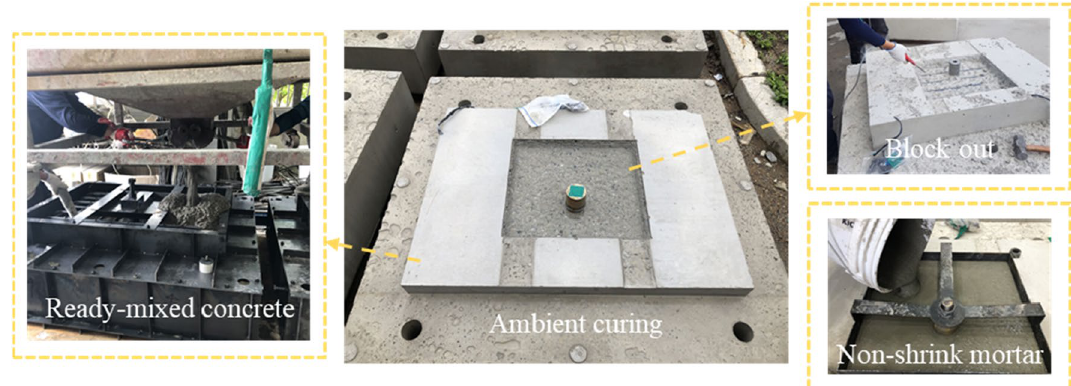
Figure 5. Manufacturing process of bridge bearing anchor.